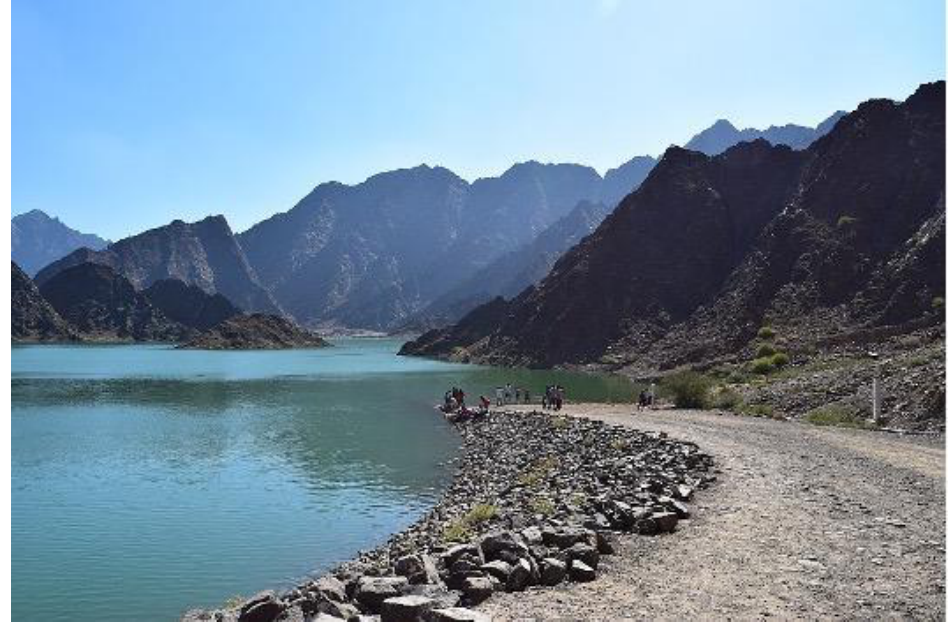
Figure 9. The Hatta dam project location